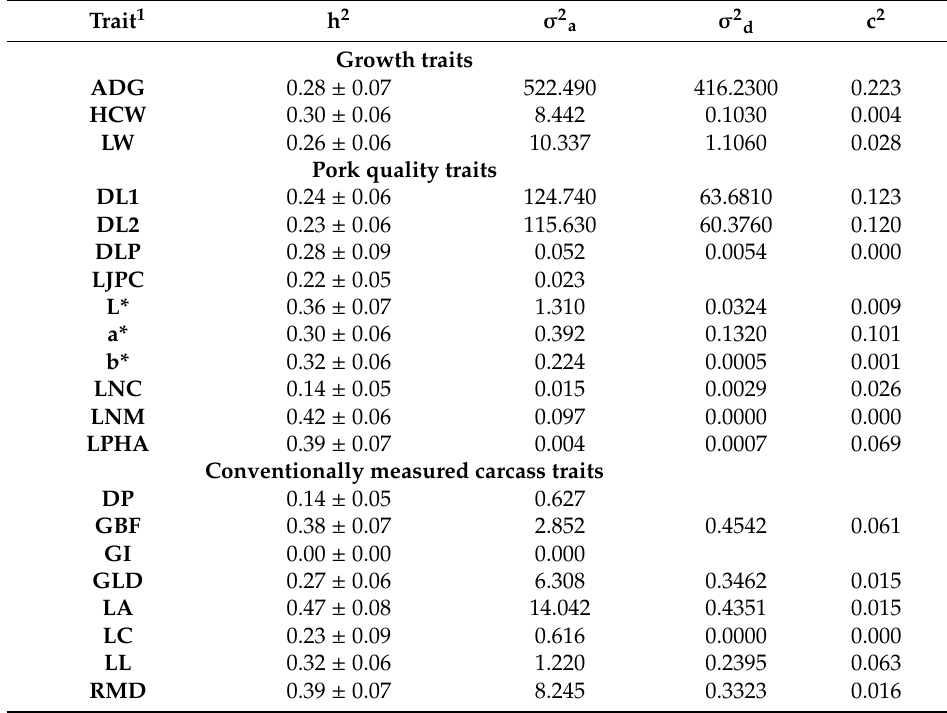
Table 6. Estimates of heritability (h 2 ), additive genetic variance ( σ 2 a ) and variance for the permanent environmental e ff ect of dam-litter ( σ 2 d ) for growth, pork quality and conventionally measured carcass